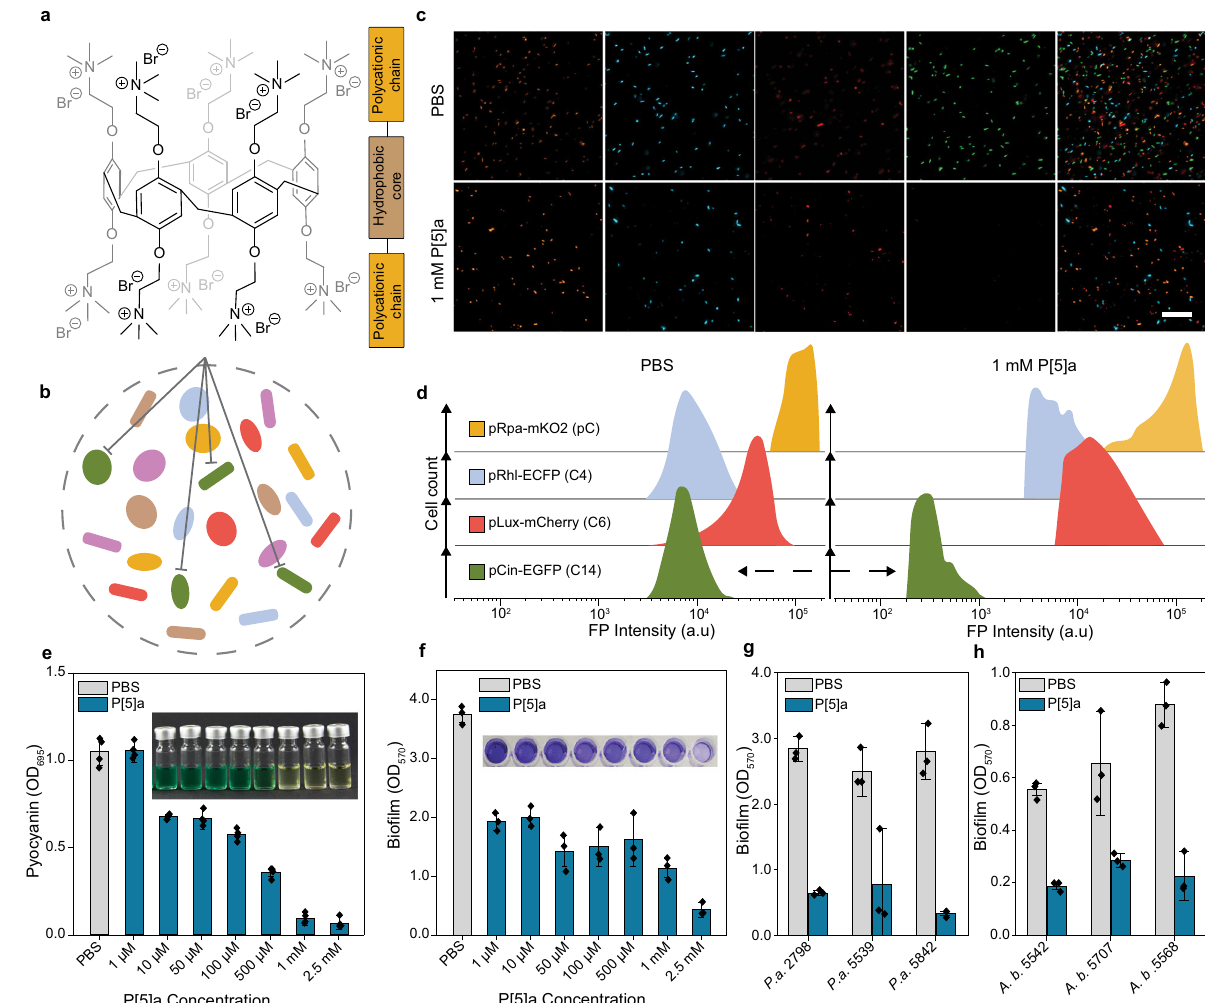
Fig.2|P[5]aselectiveforprolongedacylHSLsofPseudomonasaeruginosaand Acinetobacter baumannii, resulting in an inhibition of bio fi lm and toxins. a Chemicalstructureof the synthetichost P[5]awhichdemonstrated thestrongest interaction with HSLs with longer acyl chains, highlighting the hydrophobic core cavity (brown box), fl anked on both sides by the polycationic hydrophilic residues (orange boxes). b Schematic of a combined microbial community, where P[5]a speci fi cally inhibits strains utilizing HSLs with longer acyl chains for communica- tionandsynchronization,asseenin( c )and( d ). c Fluorescencemicroscopyimages of a combined microbial community of E. coli cells consisting of four different strainswithaunique fl uorescentprotein(pRhl-mKO2orangeforC4,pLux-CFPcyan for 3-oxo-C6, pCin -GFP green for 3-OH-C14:1 and pRpa-mCherry red for pC HSL) that each detect a different HSL, demonstrate that P[5]a speci fi cally and pre- ferentiallyinteractswithHSLsthatcontainlongeracylchains.TheadditionofP[5]a results in the inhibition of the pCin -GFP, sensing the long chain 3-OH-C14:1 HSL.